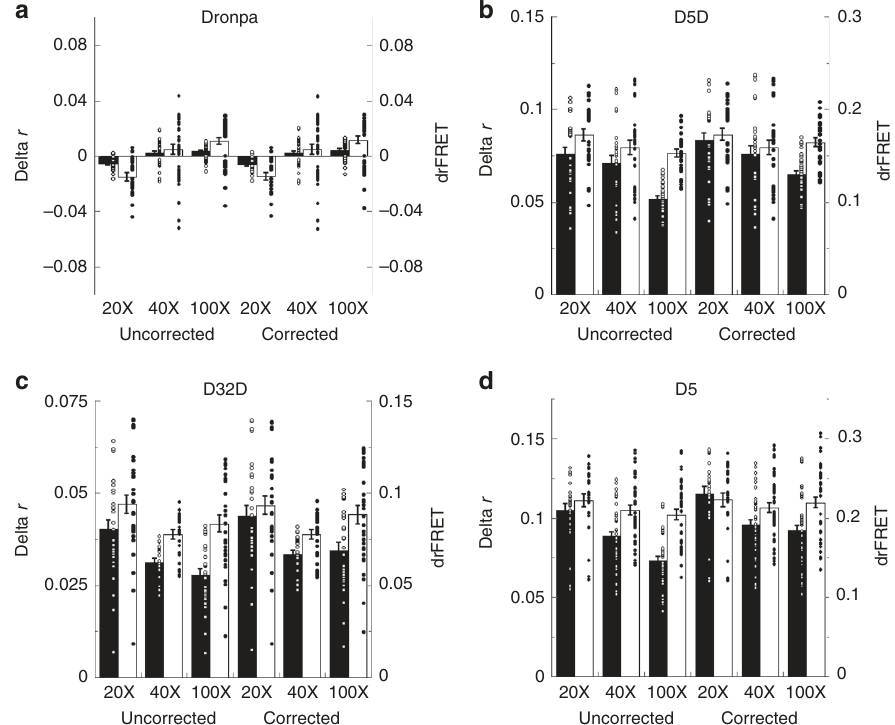
Fig. 4 psAFRET measurements using low and high NA objective lenses. COS-7 cells expressing a Dronpa ( n = 21, 39, and 39 for the 20X, 40X, and 100X, respectively), b D5D ( n = 30 for each objective lens), c D32D ( n = 30, 24, and 30 for the 20X, 40X, and 100X, respectively), or d D5 ( n = 24, 42, and 45 for the 20X, 40X, and 100X, respectively) were imaged using either a 20X/0.75 NA, 40X/1.0 NA, or 100X/1.4 NA objective lens as indicated. The anisotropy during photoswitching was determined, plotted as a function of the fl uorophore photoswitched, and the data points representing ~ 80% of the fl uorescence were fi tted to linear equations. These were used to determine the anisotropy before and after photoswitching. The difference in anisotropy (delta r, black columns) is shown compared with its conversion to drFRET ef fi ciency (white columns) using Eq. (2). As indicated, data are uncorrected or corrected for use of high NA objective lenses using the Axelrod correction. Data represent mean ± sem ( n = 21, 39, and 39 for 20X, 40X, and 100X, respectively, in ( a ); n = 30 for each in ( b ); n = 30, 24, and 30 for 20X, 40X, and 100X, respectively, in ( c ); n = 24, 42, and 45 for the 20X, 40X, and 100X, respectively, in ( d )). ANOVA and Tukey – Kramer test results are listed in Supplementary Table 1. Circles overlaid on columns in the bar graphs represent individual data points. Source data are provided as a Source Data fi